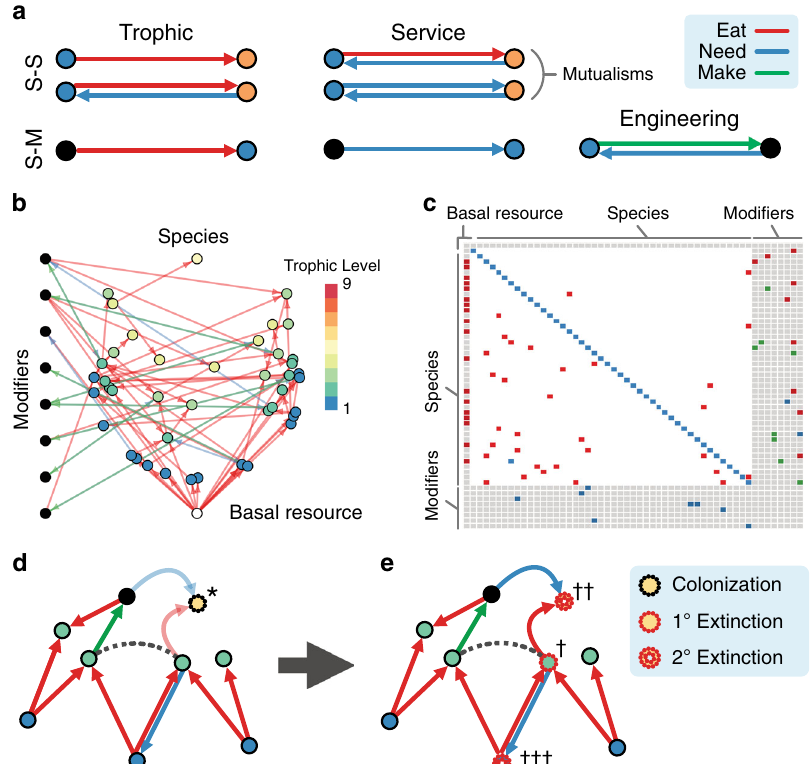
Fig. 1 Model framework for ecological networks with multitype interactions and ecosystem engineering. a Multitype interactions between species (colored nodes) and abiotic modi fi ers (black nodes). Trophic and mutualistic relationships de fi ne both species – species (S – S) and species – modi fi er (S – M) interactions; an engineering interaction is denoted by an engineer that makes a modi fi er, such that the modi fi er needs the engineer to persist. b An assembling food web with species (color denotes trophic level) and modi fi ers. The basal resource is the white node at the bottom of the network. c The corresponding adjacency matrix with colors denoting interactions between species and modi fi ers. d A species (*) can colonize a community when a single trophic and all service requirements are met. e Greater vulnerability increases the risk of primary extinction via competitive exclusion (competition denoted by dashed line) to species ( † ). The extinction of species ( † ) will cascade to affect those connected by trophic ( †† ) and service ( ††† )